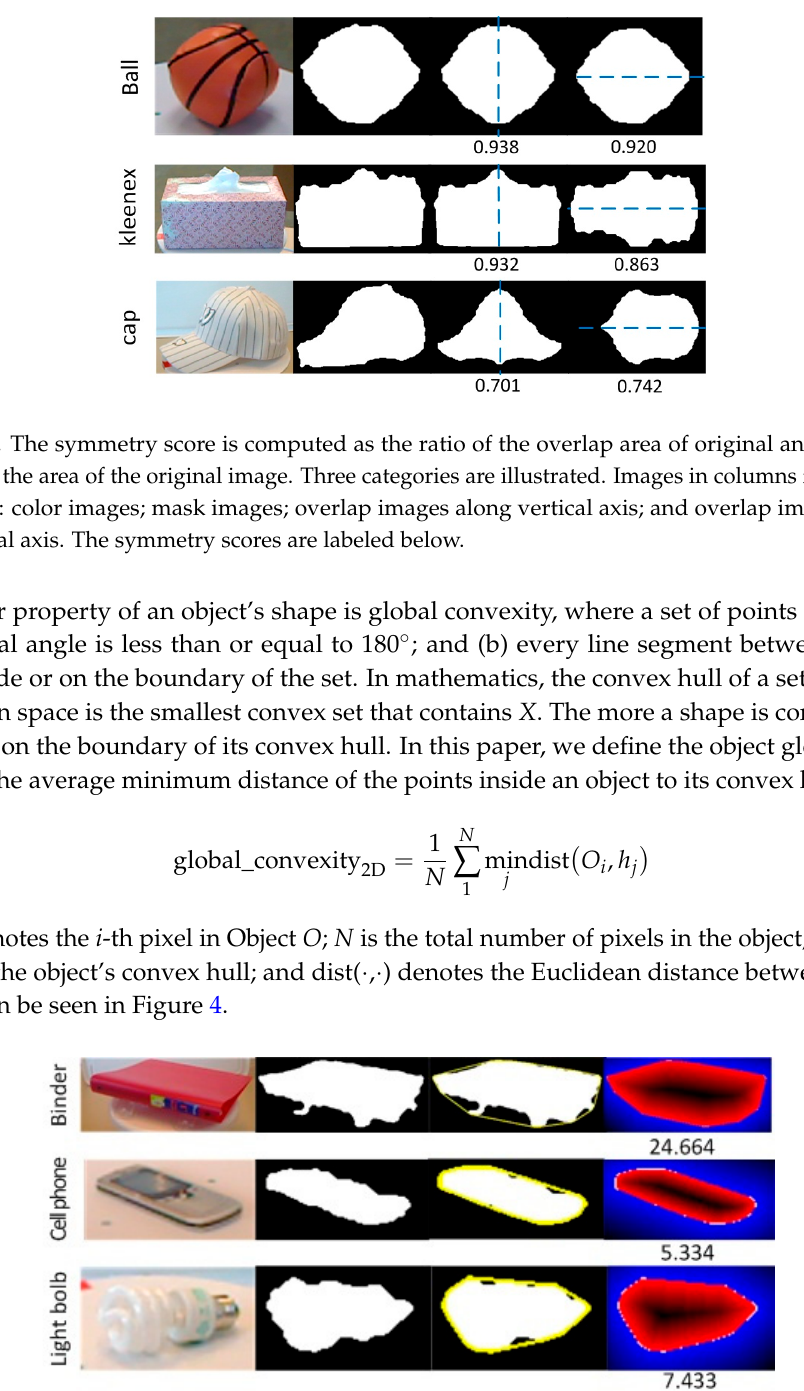
Figure 4. Global convexity is measured as the average distance of the points from an object to its convex hull. Three categories are illustrated. Images in columns from left to right are: color images; mask images; the convex hull; and the distance of points to the convex hull. The convex hull is highlighted in yellow. The different distances are colored in different colors and the global convexity scores are labeled below.